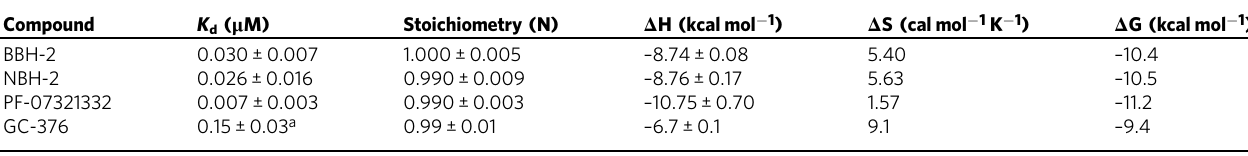
Table 1 Binding af fi nities of nitrile warhead-containing inhibitors BBH-2, NBH-2, and PF-07321332 determined by isothermal titration calorimetry ( K d and thermodynamic parameters Δ H, Δ S, and Δ G of binding). Compound K d ( μ M)